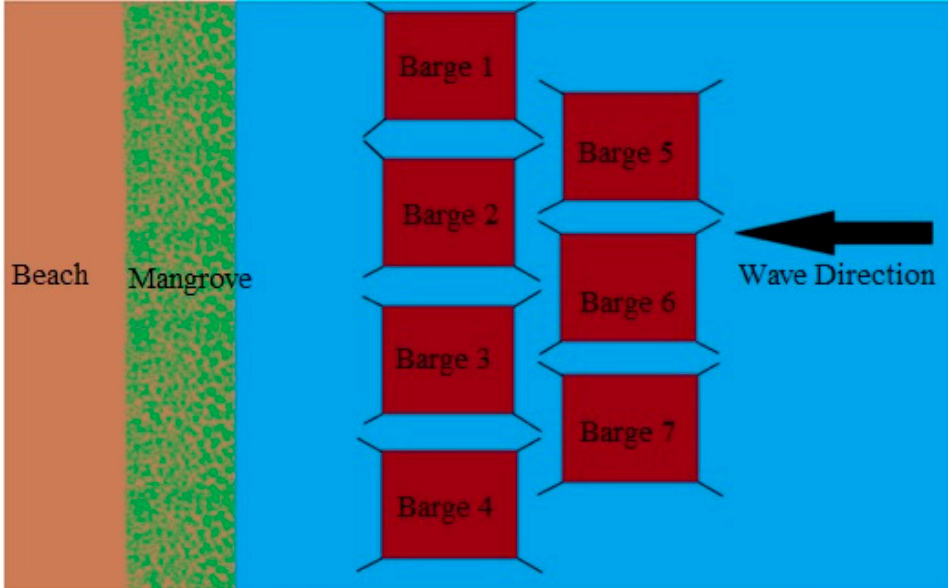
Figure 9. Moored barges in series with mangroves in plain view.